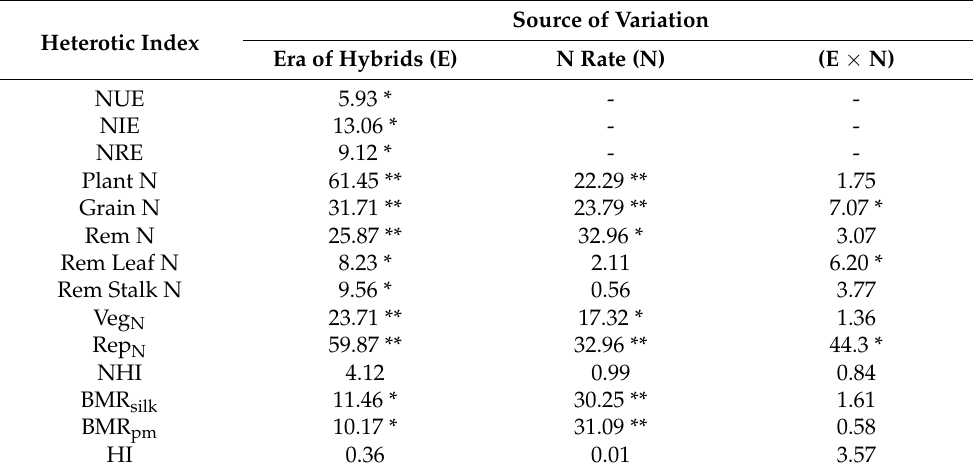
Table 3. Mean squares from the ANOVA of heterosis for NUE, GY and related traits of hybrids (F value).